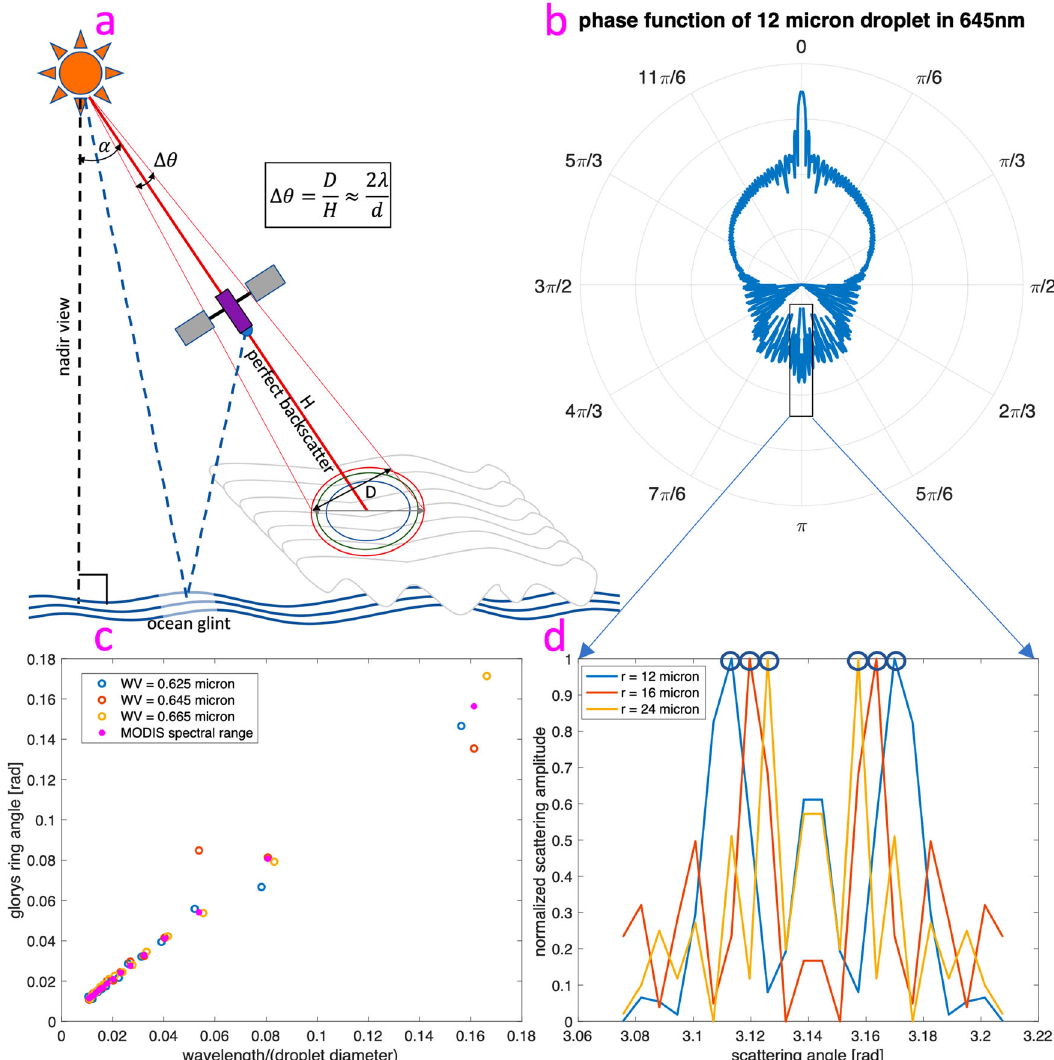
Fig. 1 How optical glory yields a cloud droplet diameter. a Glory ’ s geometry — The glory angular size, Δθ ≡ D/H , with H denoting the distance between the glory ’ s center and the satellite and D , the diameter of the inner (red) ring in the satellite image, projected onto the normal to H , is approximately equal to 2 λ / d with d being the droplet size and λ , the wavelength of (red) light. b Polar diagram of the scattered light logarithmic intensity vs. the scattering angle. Because of the large optical size of cloud droplets, most of the incident radiation is scattered forward and the entire diagram is not only complex, with intricate details but also highly sensitive to small changes in wavelength, particle size, and index of refraction. A mere 20 nm change in the droplets radius, a relative change of 0.2%, yields doubling of the glory peak amplitude. Yet, despite such sensitivity, c , based on the exact solution for scattering by a water sphere, shows that a simple diffraction-like scaling suf fi ces to link the angular size of the glory to the scaled inverse droplet diameter, λ / d . d Closeup of the phase function near perfect backscatter (glory) as demarcated by the black rectangle of b . Changes in the width of the glory ring are shown for three droplet